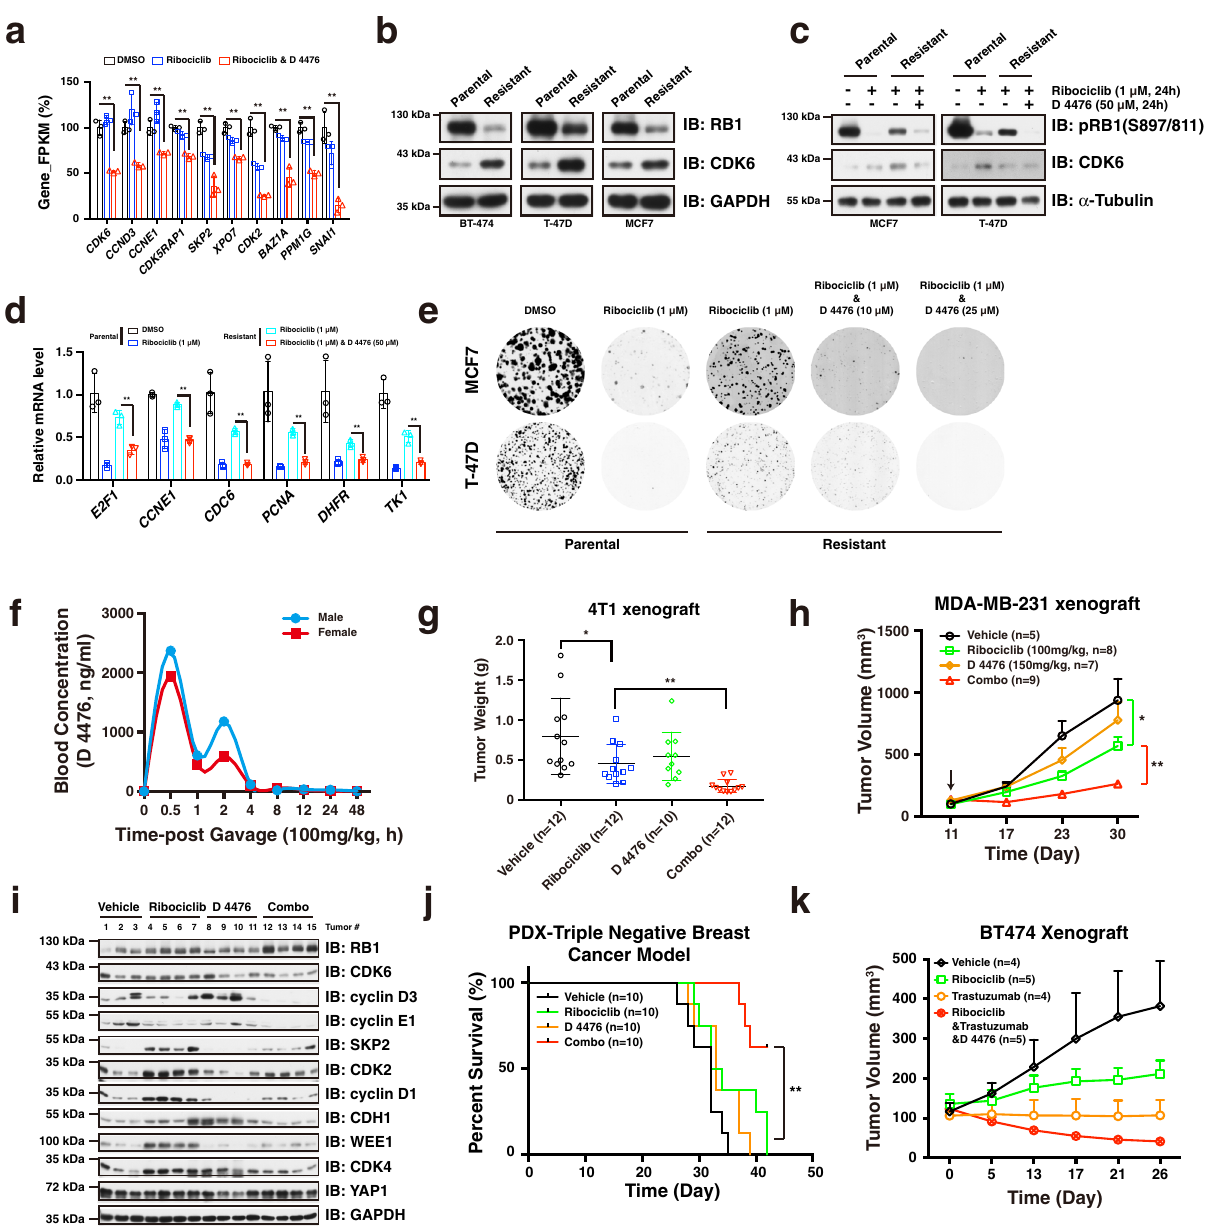
Fig. 7 Employment of D 4476 potentiates the therapeutic ef fi cacy of ribociclib. a Expression of a cohort of genes driving acquisition of CDK4/6i resistance was signi fi cantly suppressed in the context of combination treatment ( n = 3). The P values were calculated by Student ’ s t-test (two-sided). ** P < 0.01. b Immunoblot showing the RB1 and CDK6 protein levels in normal parental and CDK4/6i-resistant daughter breast cancer cells. c Immunoblot showing that addition of D 4476 potentiated the suppressing ef fi cacy of ribociclib in CDK4/6i resistant cells. d RT-qPCR analysis showing that combination of D 4476 overcomes the CDK4/6i resistance in suppressing cell cycle gene transcription in CDK4/6i-resistant MCF7 cells ( n = 3). The P values were calculated by Student ’ s t-test (two-sided). ** P < 0.01. Cells were treated with ribociclib (1 μ M), D 4476 (50 μ M), and ribociclib-D 4476 combination, respectively, for 24 h. e Combination of D 4476 potentiated the ef fi cacy of ribociclib in suppressing colony formation in MCF7 and T-47D resistant breast cancer cells. f Pharmacokinetic curve of CK1 ε inhibitor D 4476 in vivo. A single dose of D 4476 was administrated in ICR mice and blood concentration of D 4476 at indicated time points was measured. g 4T1 xenograft assay showing that combination of D 4476 with ribociclib led to decreased tumor weight. The P values were calculated by Student ’ s t-test (two-sided). * P < 0.05, ** P < 0.01. h Combination of D 4476 with ribociclib retarded MDA-MB-231 tumor growth in vivo. Statistical differences were assessed by two-way ANOVA (two-sided). * P < 0.05, **: P < 0.01. i Immunoblot analysis of MDA-MB-231 tumors treated with vehicle, ribociclib, D 4476, and Combo (ribociclib-D 4476), respectively. j Combination of D 4476 with ribociclib resulted in signi fi cant improvement of overall survival in triple negative breast cancer PDX model. The P value was calculated by log-rank test. ** P < 0.01. k Combination of ribociclib, D 4476 and Trastuzumab retarded BT-474 tumor growth. Data are presented as mean values ± SEM. The relevant raw data and uncropped blots are provided in Source